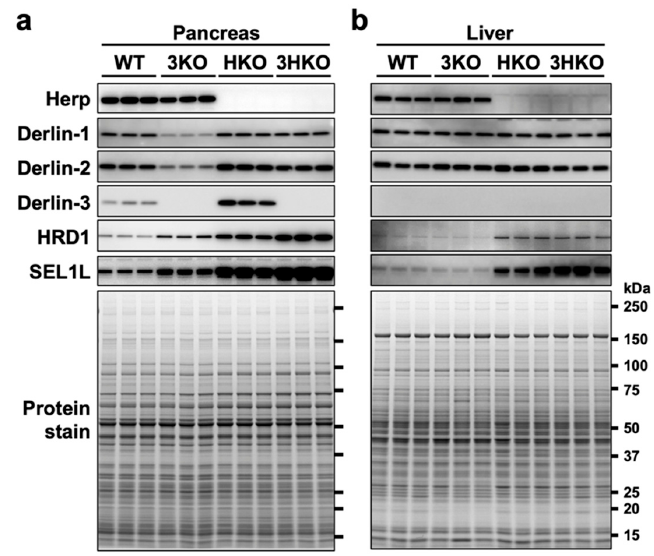
Figure 3. The e ff ect of Derlin-3 and Herp deficiency on the protein expression levels of ER-associated protein degradation (ERAD) factors. WT, 3KO, Herp-deficient (HKO), and Derlin-3 / Herp double-deficient (3HKO) mice ( n = 3) were fasted for 12 h before euthanasia. Pancreas ( a ) and liver ( b ) homogenates (each mouse per lane) were subjected to Western blotting using antibodies indicated on the left side. Bottom images (Protein stain) show protein bands in the gel stained with GelCode Blue Stain Reagent to check for equal